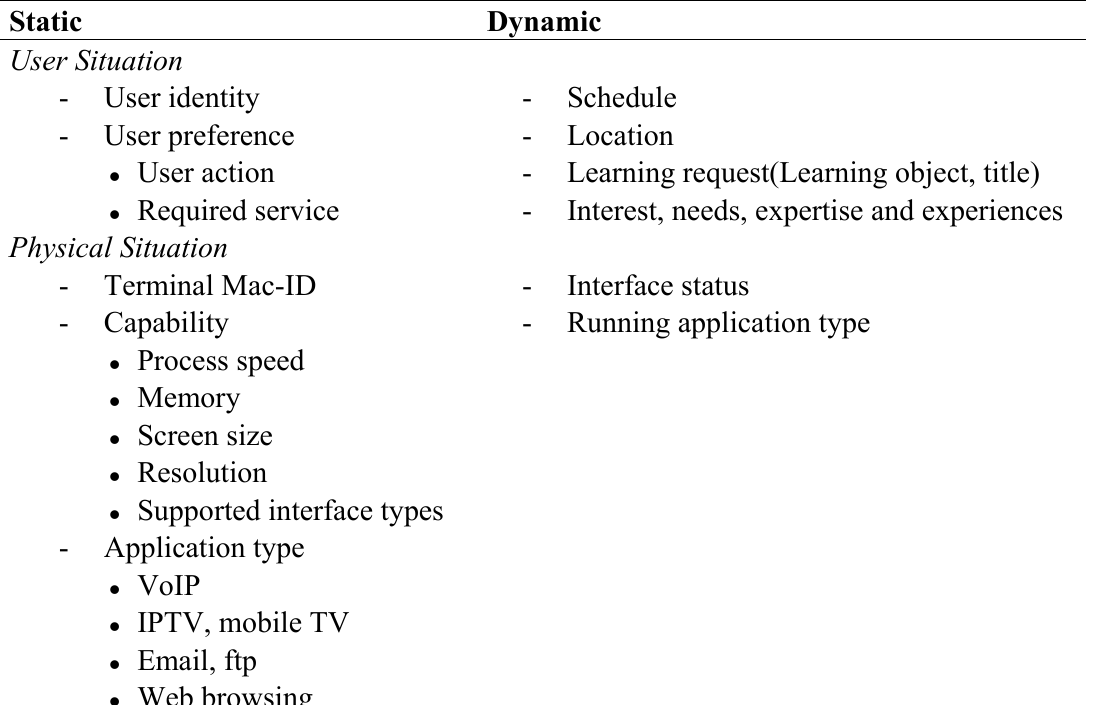
Table 1. Context model based on Hybrid